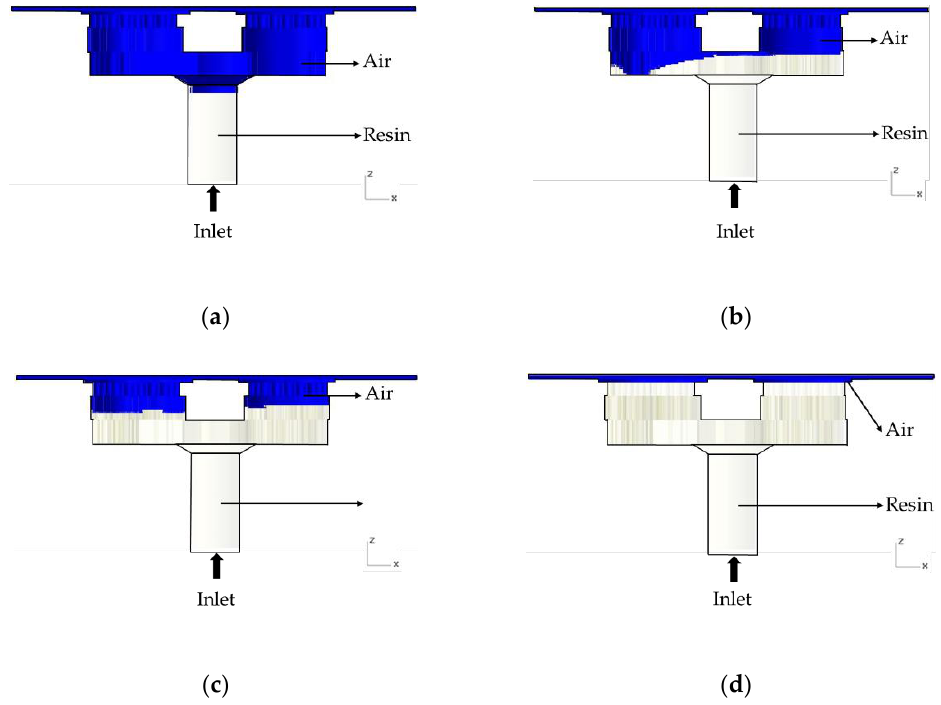
Figure 10. The flow rate is 0.01 cm 3 /s. ( a ) Filling 10%; ( b ) Filling 30%; ( c ) Filling 50%; ( d ) Filling 70%. Table 5. Experiment and simulation results of flow trend in the plate. Since the filling process of the 259 experiment is not easy to observe, there is a large gap in the total filling time. Therefore, the time 260 difference is used to determine whether the trend is similar.